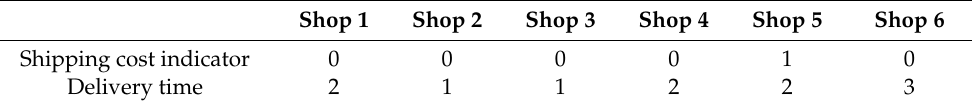
Table 10. Numerical solution results of the initial master (shops). Shop 1 Shop 2 Shop 3 Shop 4 Shop